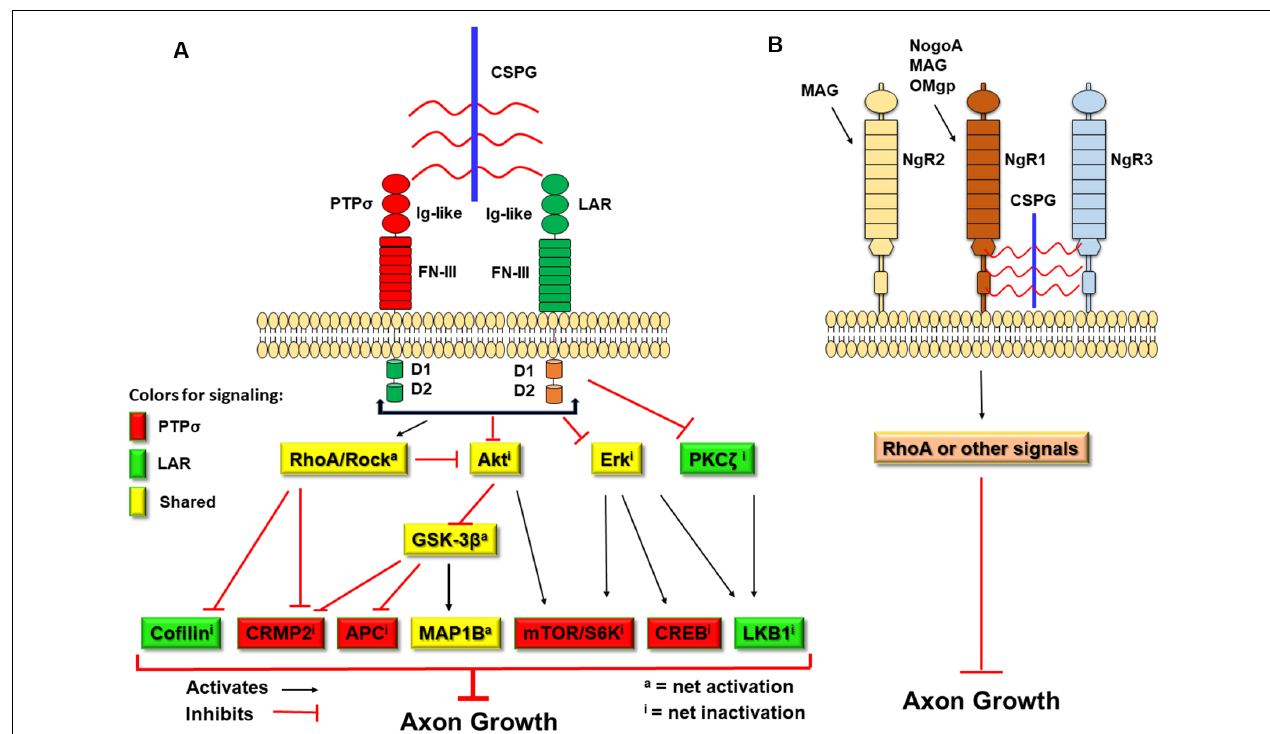
FIGURE 2 | Schematic of the transmembrane receptors for CSPGs and myelin-associated inhibitors and the signaling pathways downstream of two receptor protein tyrosine phosphatases (RPTPs). CSPGs induce growth inhibition by binding and activating several transmembrane receptors, including PTP σ , leukocyte common antigen related (LAR), NgR1, and NgR3. (A) Intracellularly, activation of PTP σ and LAR by CSPGs activate RhoA/ROCK signaling and inactivate Akt and Erk pathways. However, the two receptors use distinct pathways downstream of RhoA/ROCK, Akt/GSK-3 β , and Erk signals to mediate inhibition of axon growth by CSPGs. CSPGs also can bind NgR1 and NgR3 to inhibit axon growth. Intracellularly, NgR functions are mediated mainly by the Rho pathway. Red-filled: signals conveyed by PTP σ . Green-filled: signals conveyed by LAR. Yellow-filled: signals shared by both PTP σ and LAR. Ig-like, immunoglobulin-like domains; FN-III,